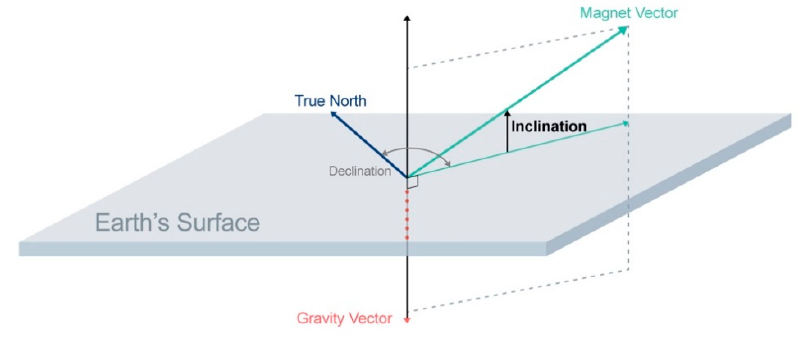
Figure 3. Parameters of the magnetic field.